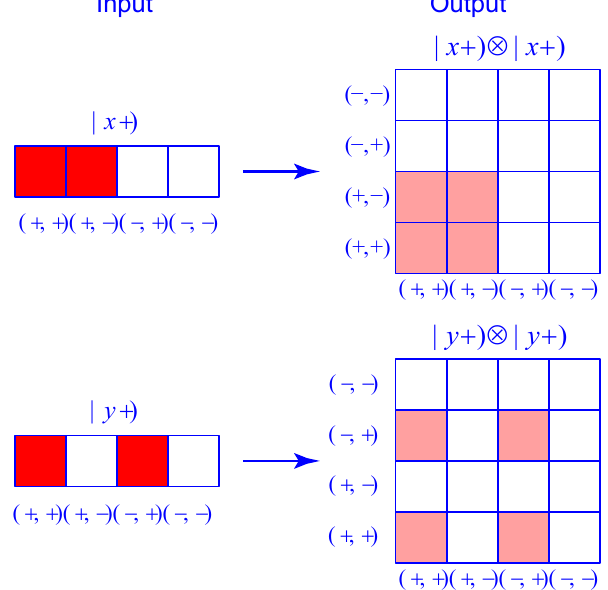
Figure 4: Inputs and outputs of a hypothetical toy bit cloning machine. In order to represent a two toy bit state, the ontic state space of a single toy bit is represented along one dimension. For the outputs, the horizontal axis represents the first toy bit and the vertical axis represents the second toy bit. Dark red represents ontic states occupied with 50% probability and light red represents those occupied with 25% probability. The inputs overlap on an ontic state that they both assign 50% probability, but the outputs only overlap on an ontic state that they both assign 25% probability.